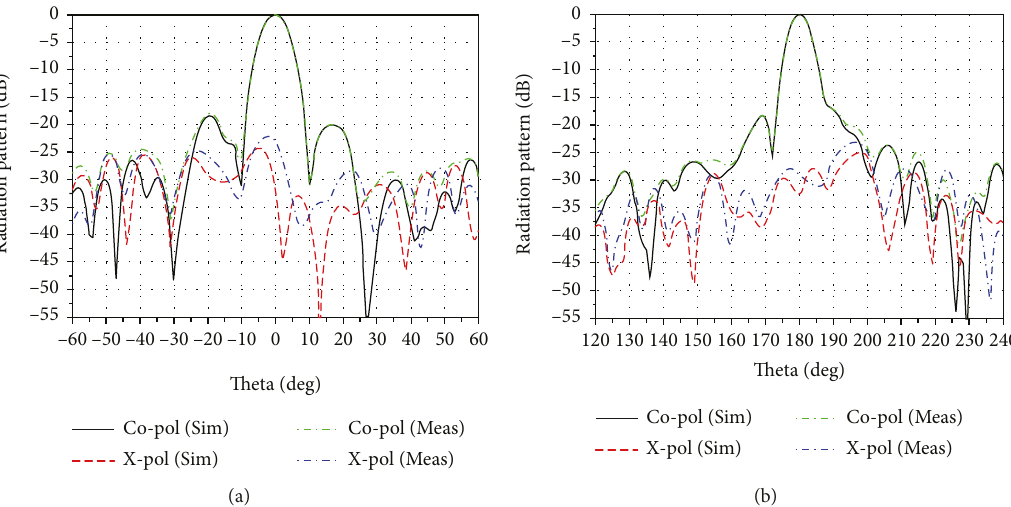
(Meas)Co-pol (Meas) (Sim)Co-pol (Sim) X-pol X-pol Figure 9: Measured and simulated radiation patterns of the fabricated re fl ectarray at (a) 11.6GHz and (b) 14.6GHz. The LHCP and RHCP feeds are placed on each side of the re fl ectarray,